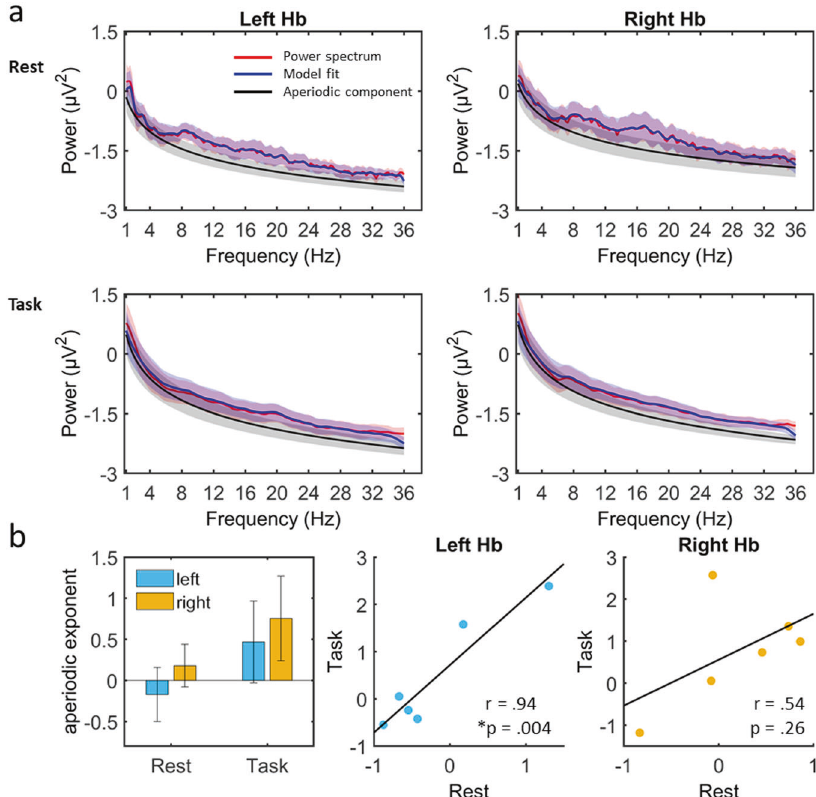
Fig. 2 Power pro fi le of habenular recordings. a Power pro fi le for resting state (top) and task (bottom) shown in red. Power fi t via fooof algorithm is shown in blue and aperiodic component shown in black. Shading indicates standard error of mean. Note the overlapping colour and SEM shading of the power spectrum, the model fi t to the power spectrum and the aperiodic component. b The bar plot (left) shows the aperiodic component with no signi fi cant differences between left (blue) and right habenula (yellow) with greater left habenula aperiodic component in task relative to rest (Error bars indicate stand error of mean). The scatter plots of the aperiodic components between rest and task shows a signi fi cant positive correlation for left habenula (blue) but not for right habenula (yellow). Bonferroni correction * P < Aperiodic component – 1/f For resting data, the group mean R 2 values for left habenula power spectral fi t was 0.92 and that for the right habenula power spectral fi t was 0.91. For task data the group mean R 2 values for left habenula power spectral fi t was 0.90 and that for the right habenula power spectral fi t was 0.93. The rest and task data showed similar power pro fi les for left and right habenula (Fig. 2). Individual patient ’ s spectrum are shown in supplementary (Supplementary Fig. 1). On an exploratory basis, we assessed the relationship between aperiodic components of rest and task. Left habenula seemed to show increased aperiodic component in task when compared to rest (mean = − 0.17, SD = 0.81; t(5) = − 2.97, P = 0.03 ) which however did not survive multiple comparison (Bonferroni signi fi cance P < 0.013). Right habenula activity did not show signi fi cant difference (mean = 0.18, SD = 0.63; t(5) = − 1.32, P = 0.24 ) (Fig. 2b left). The aperiodic component values were signi fi cantly correlated between rest and task data for the left habenula ( r = 0.94, P = 0.004 ) (Bonferroni signi fi cance P < 0.025 ) but not for right habenula ( r = 0.54, P = 0.26 ) (Fig. 2b, middle and right panel). Aperiodic component ’ s relationship with depression severity In our main hypothesis, we then correlated the aperiodic component with the depression severity. The left habenula aperiodic component was signi fi cantly positively correlated with depression severity ( r = 0.88, P = 0.015 ) (Bonferroni signi fi cance P < 0.025 ) (Fig. 3 left) but not the right habenula ( r = 0.20, P = 0.69 ) (Fig. 3 right). We also replicate